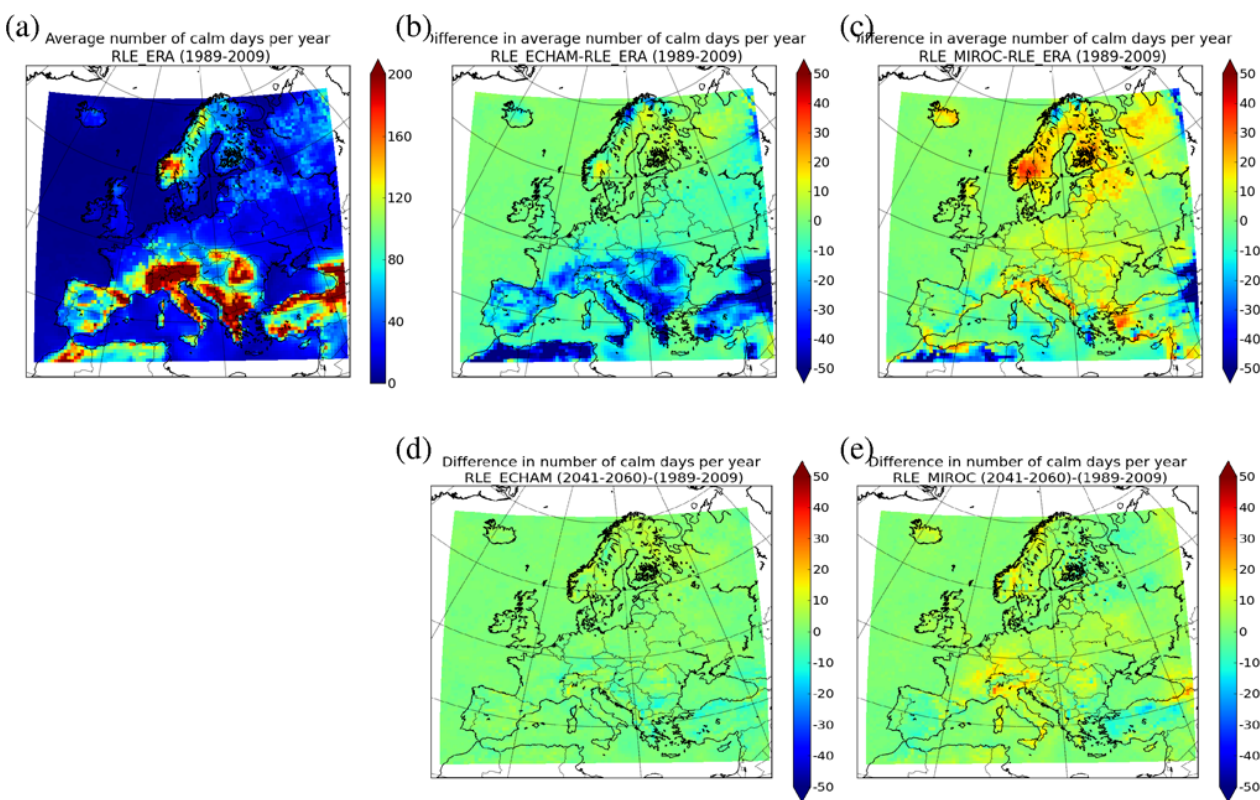
Fig. 6. Like Fig. 3, but showing the average number of calm days.